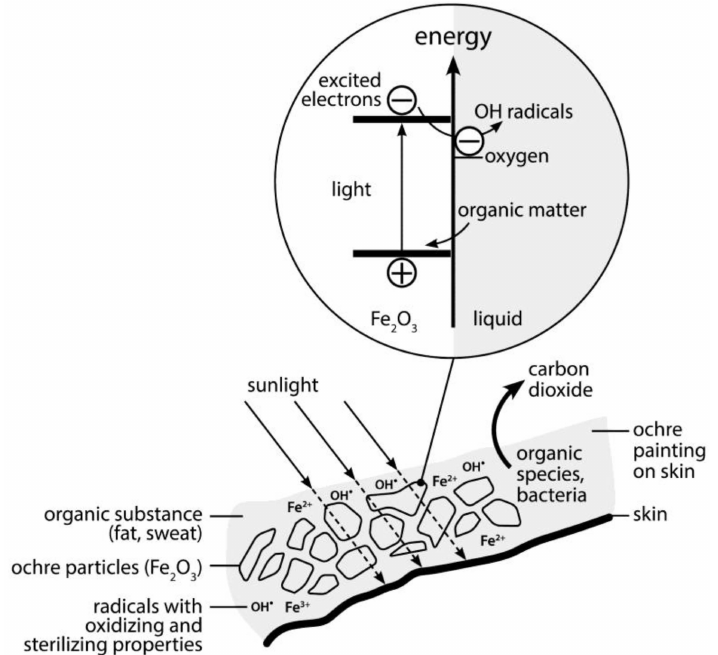
Figure 6. Scheme explaining the action of ochre (mixed with organic substances like fat) on the skin. In the outer layer visible light (with energies exceeding 2 eV) is absorbed. Electrons from the organic components are filling the empty electronic ground state and suppressing recombination of the excited electrons, which are then reducing oxygen to form peroxide and OH radicals. They eliminate smell and kill bacteria and